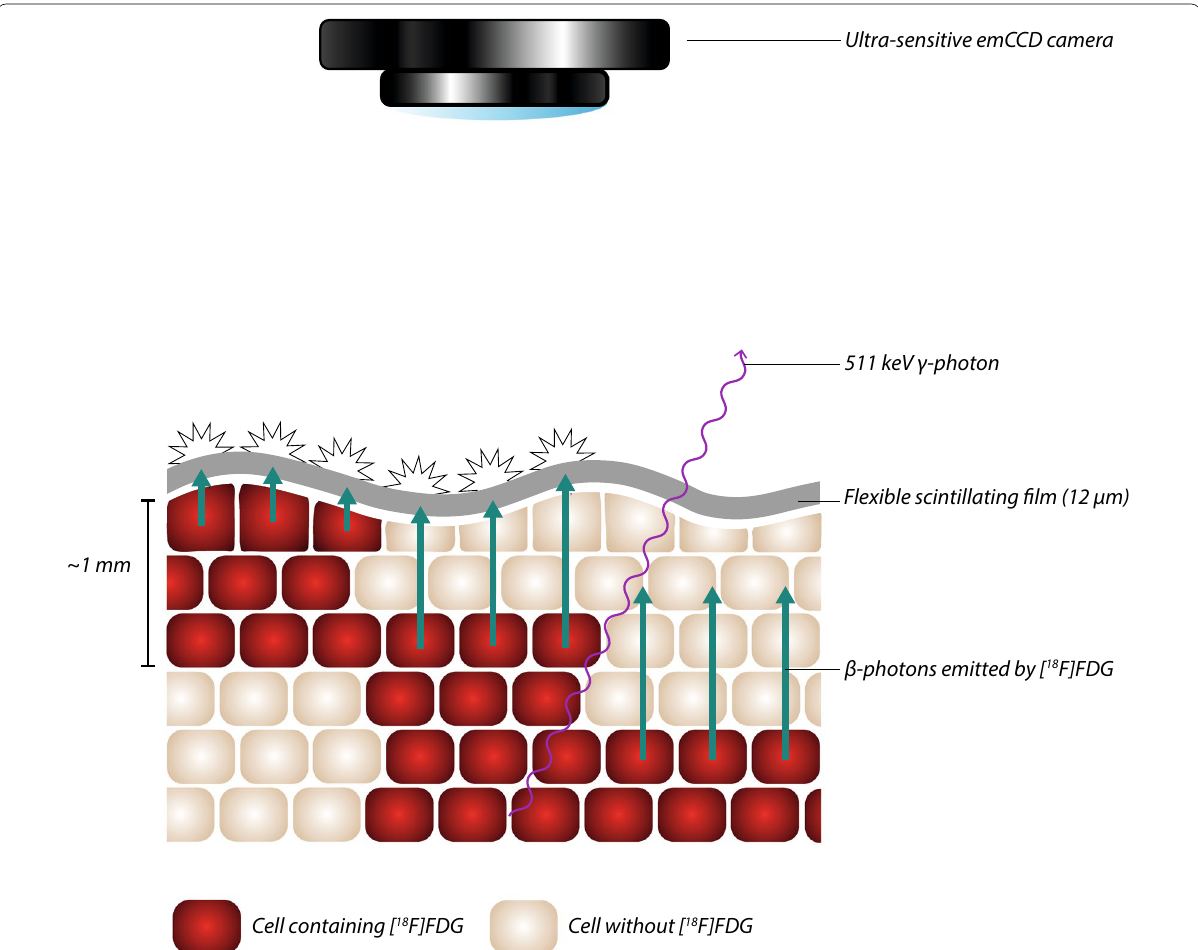
Fig. 1 Schematic representation of FAR imaging using a flexible scintillating film. Tumour cells containing a PET‑radiotracer (e.g. [ 18 F]FDG) emit β + ‑particles which are converted to scintillations by the flexible scintillator. As β + ‑particles travel a limited distance in tissue, [ 18 F]FDG containing cells are detected up to approximately 1 mm in tissue. The scintillations are measured by an ultra‑sensitive emCCD camera. The flexible scintillators 12 µm thickness makes the scintillator insensitive to 511 keV ɣ